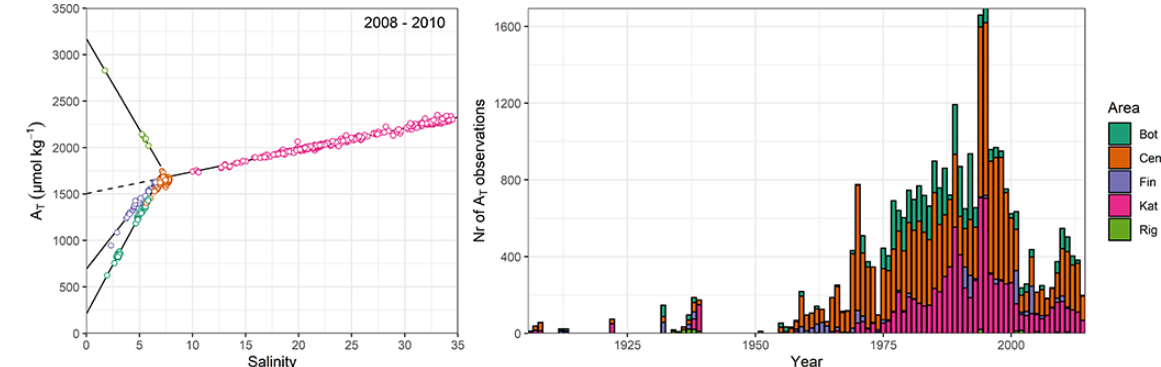
Figure 8. Different A T vs. S regimes in the Baltic Sea derived from data from 2008 to 2010 and A T – data density for the different basins as a function of time (modified after Müller et al., 2016). Abbreviations: Bot – Gulf of Bothnia; Cen – Central Baltic; Fin – Gulf of Finland; Kat – Kattegat; Rig – Gulf of